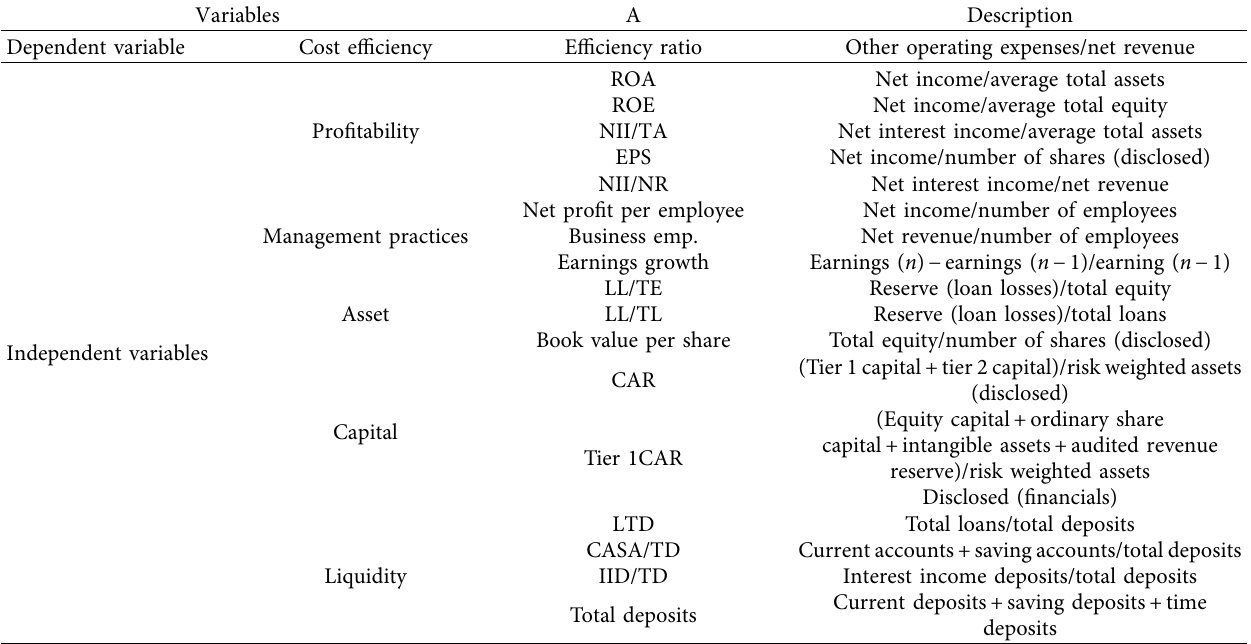
Table 1: Operational definitions.